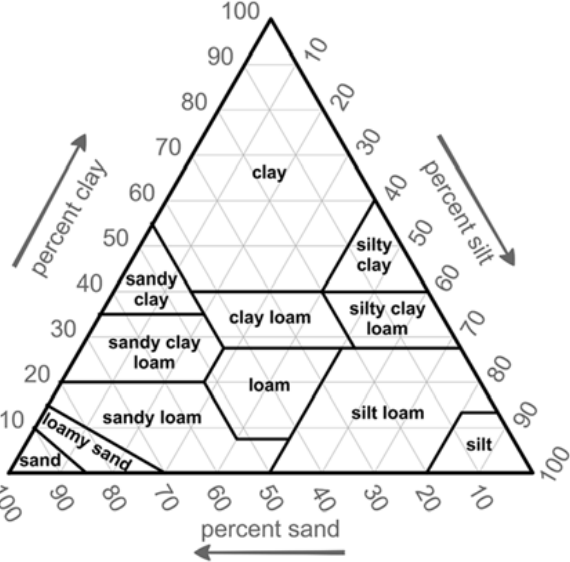
Figure 1. Soil textural triangle, as defined by the USDA. Derived from